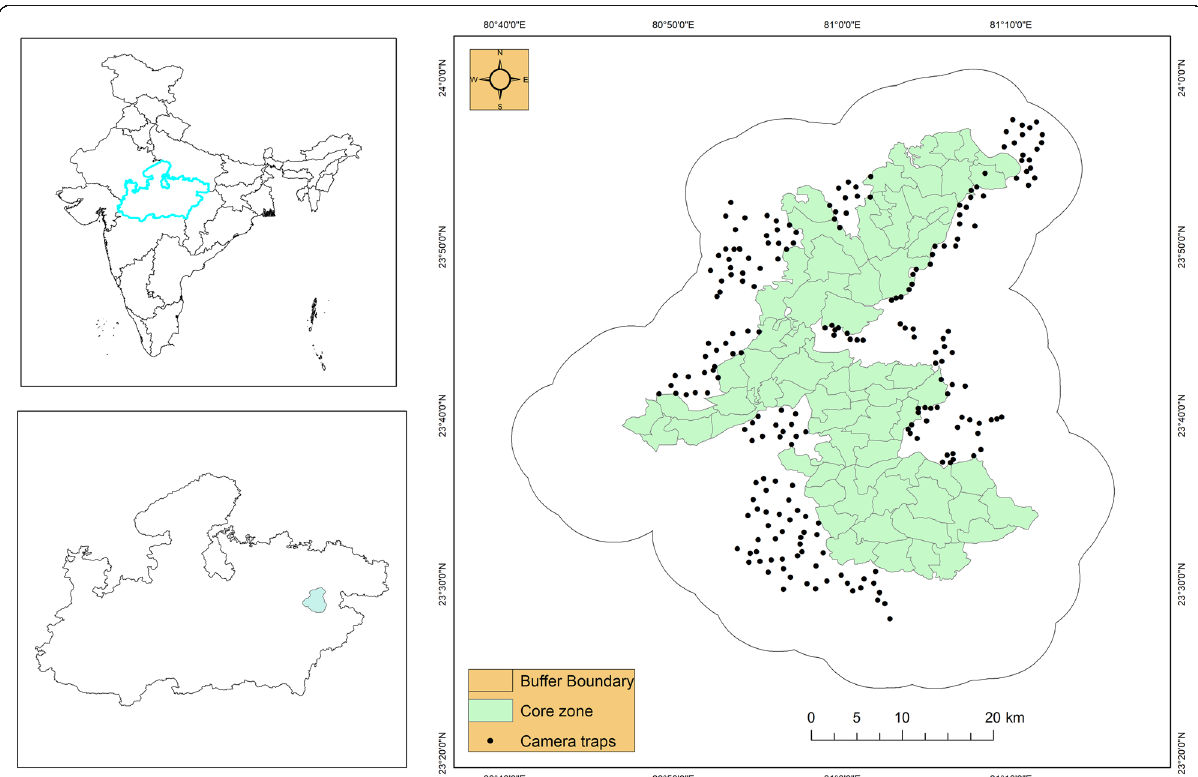
Fig. 1 Location of Bandhavgarh Tiger Reserve, Madhya Pradesh, India and the distribution of camera trap stations in the buffer zone of the